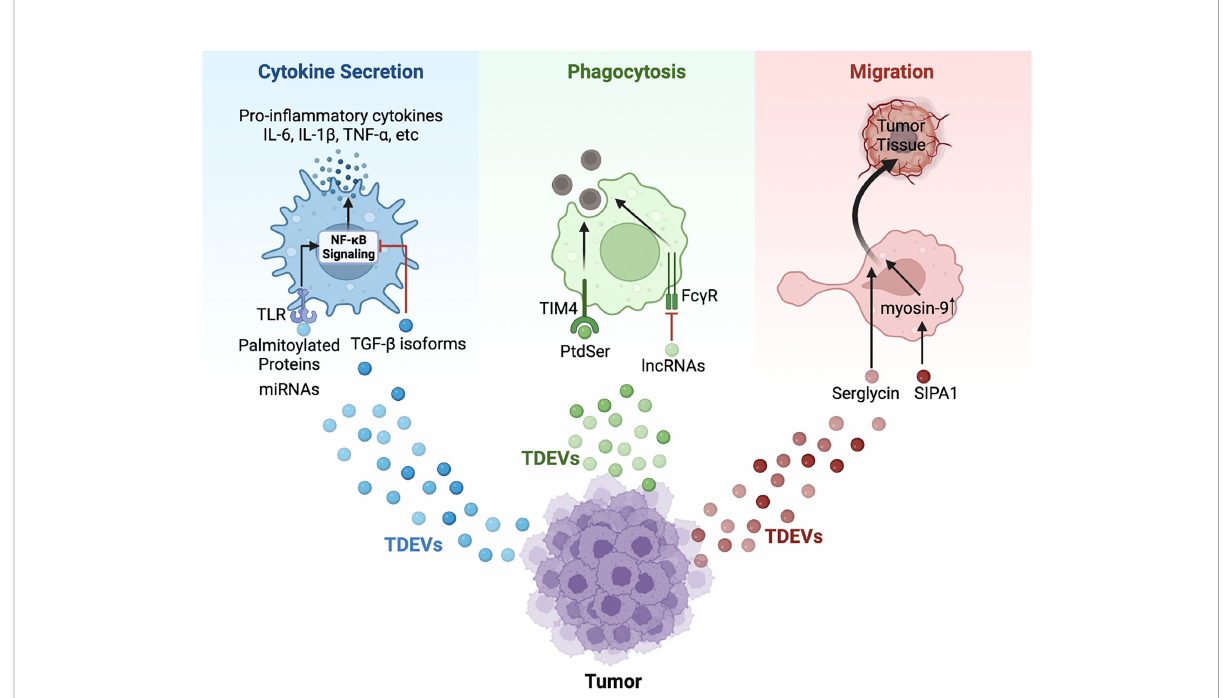
FIGURE 1 Schematic model of TDEVs in regulating the functions of macrophage. TDEVs can modulate the cytokine secretion, phagocytosis, and migration of macrophages via various signaling pathways. For cytokine secretion (Blue): Palmitoylated proteins carried by gastric cancer-derived EVs bind with TLR2 on the surface of macrophages to further activate NF- k B signaling, leading to an elevated level of pro-in fl ammatory cytokines including IL-6, IL-1 b , TNF- a and so on. Similarly, miRNAs in EVs secreted by lung cancer and breast cancer bind with TLR7/8 to induce pro-in fl ammatory cytokines secretion via the NF- k B pathway. However, HNSCC-derived EVs cargo TGF- b isoform inhibits NF- k B signaling to down-regulate the expression of pro-in fl ammatory cytokines. For phagocytosis (Green): PtdSer in apoptotic tumor-derived EVs binds with receptors such as TIM-4 to promote the phagocytosis of apoptotic cells by macrophages. However, lncRNA TUC399 contained in HCC-derived EVs down-regulates the Fc g R-mediated phagocytosis. For migration (Red): TDEVs from myeloma containing serglycin can augment macrophage migration, and SIPA1 in breast cancer-derived EVs induces elevated expression of myosin-9 in macrophages, which contributes to